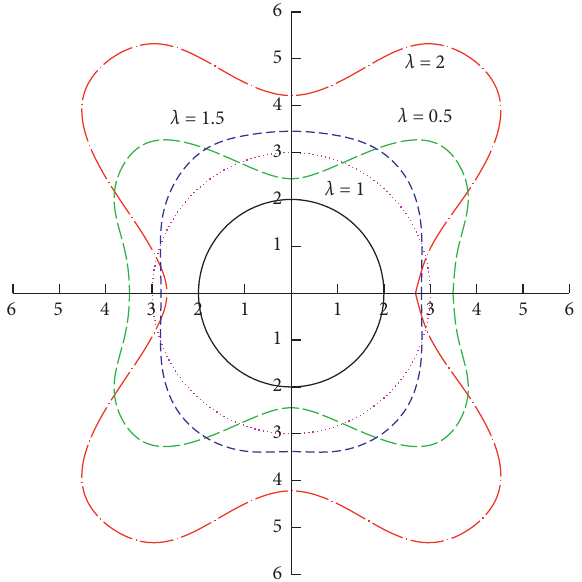
Figure 4: The distribution range of the plastic zone with different side pressure